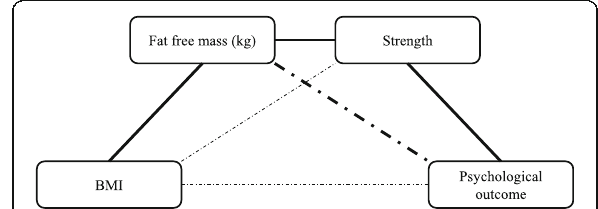
Fig. 3 Model for testing the indirect relations of BMI with psychological outcomes. There was neither an direct effect of BMI on psychological outcomes nor an indirect effect of BMI on psychological outcomes via strength. Limited indirect effects of BMI on psychological outcomes